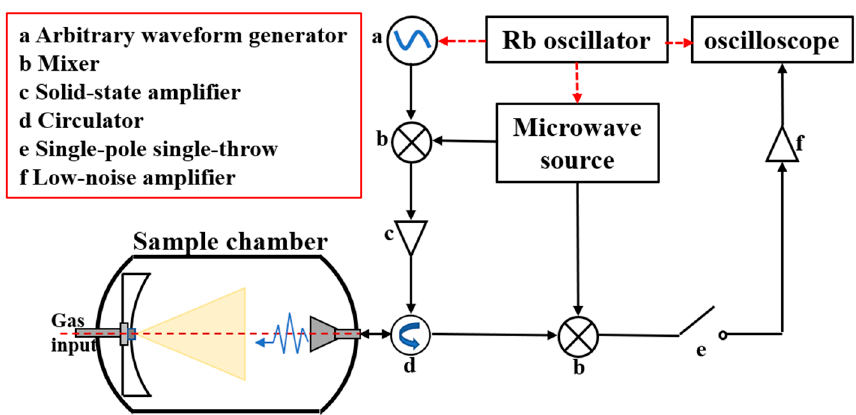
Figure 1. Schematic diagram of broadband cp-FTMW spectrometer.